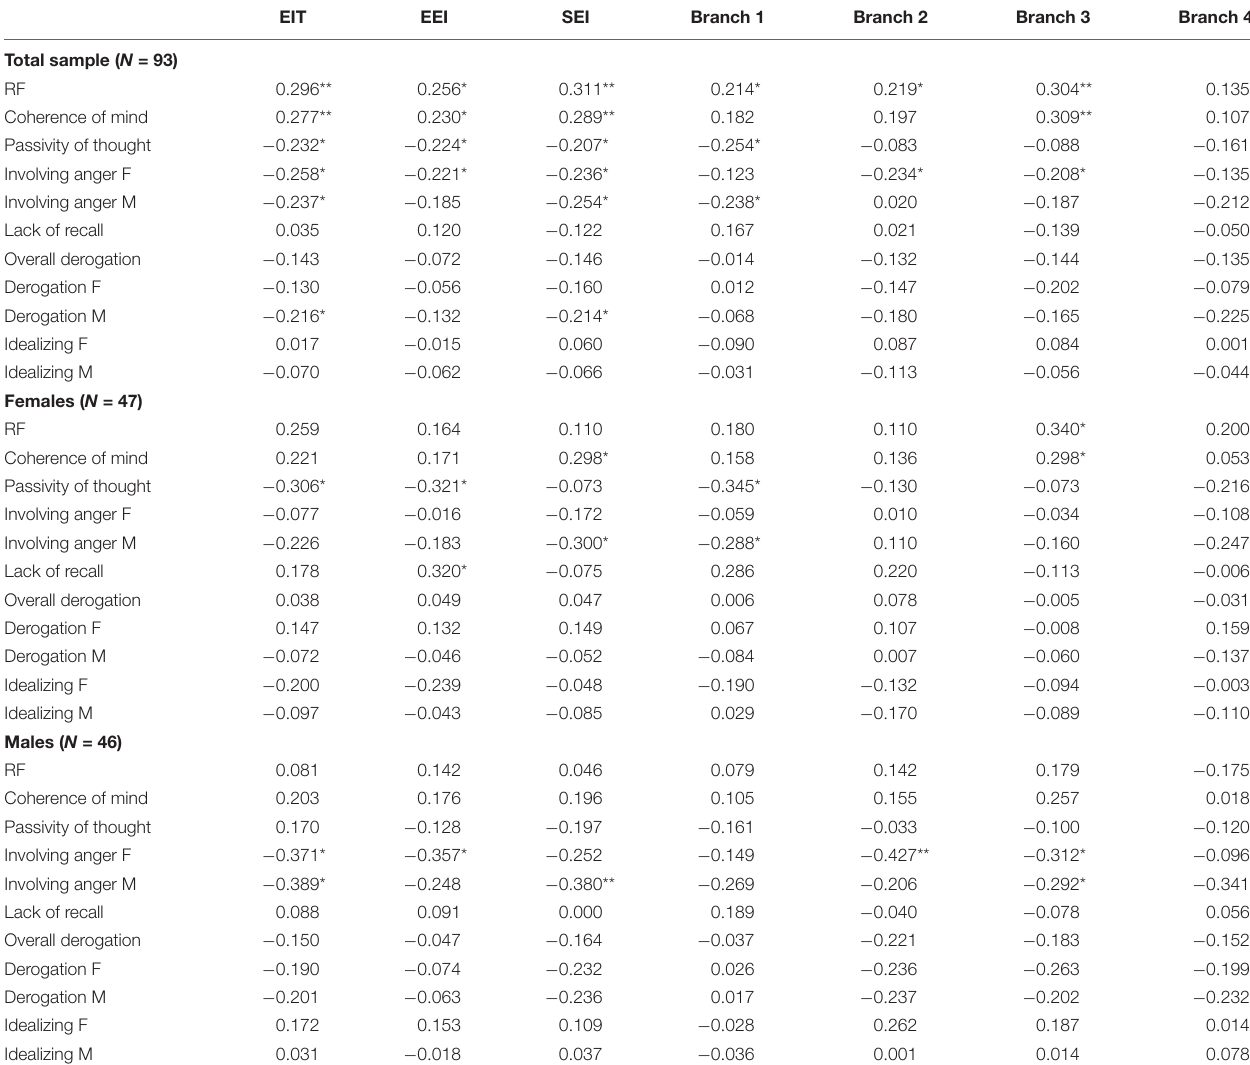
TABLE 2 | Correlations between MSCEIT scores, AAI, and RFS